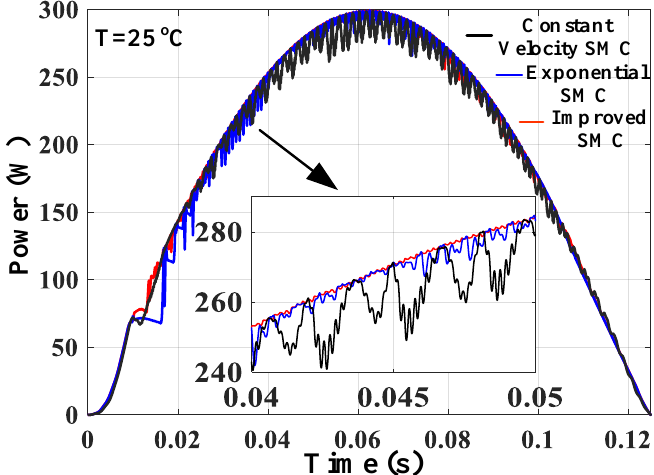
Figure 14. MPPT curve for various irradiance at a temperature of 25 °C.